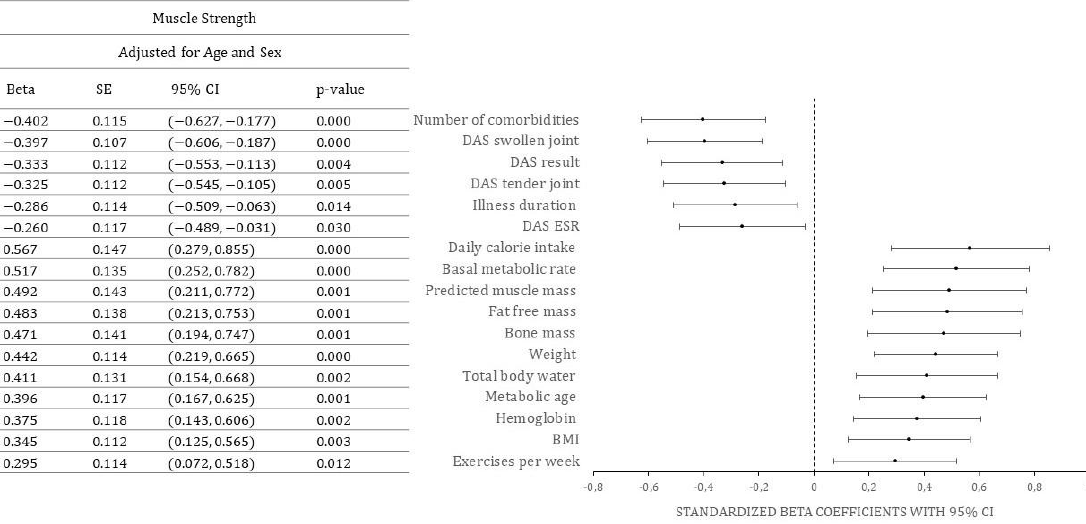
Figure 2. Predictors of muscle mass. Abbreviations: SE-standard error, CI-confidence interval, body mass index (kg/m 2 ), CI-confidence interval.